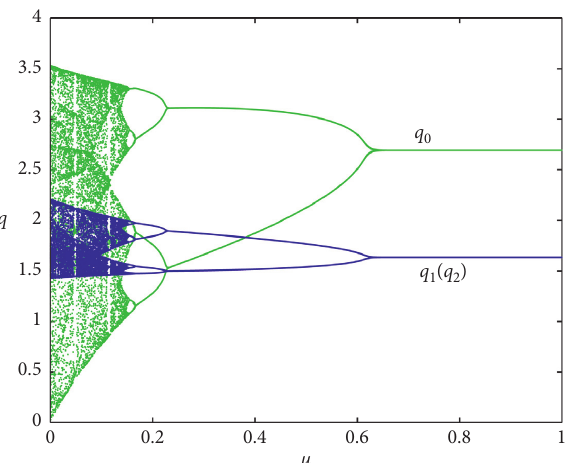
Figure 5: Bifurcation diagram for system (26) with control parameter μ